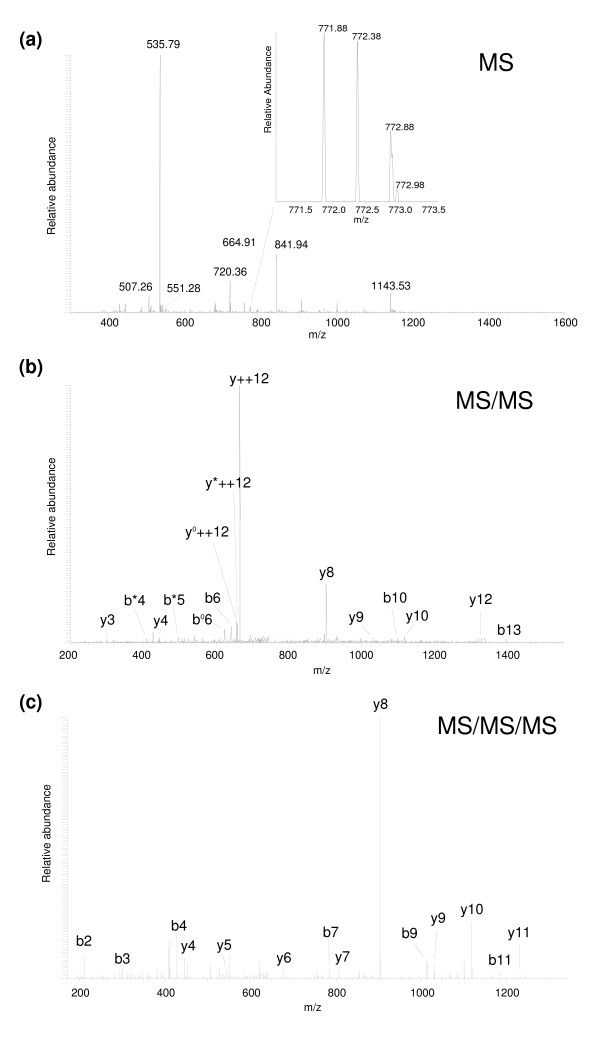
Two consecutive stages of mass spectrometric fragmentation (MS3). The precursor of peptide DVPNSQPEMVEAVK (a; see insert) was selected for fragmentation from a full scan of mass to charge ratio range. The doubly charged y12 fragment ion (b) was subsequently fragmented. Characteristic pattern for charged directed fragmentation is observed in MS3 spectra (c) and confirms the identification of the above peptide. See Steen and Mann [65] for an introduction to peptide sequencing and confidence of peptide identification. MS, mass spectrometry.